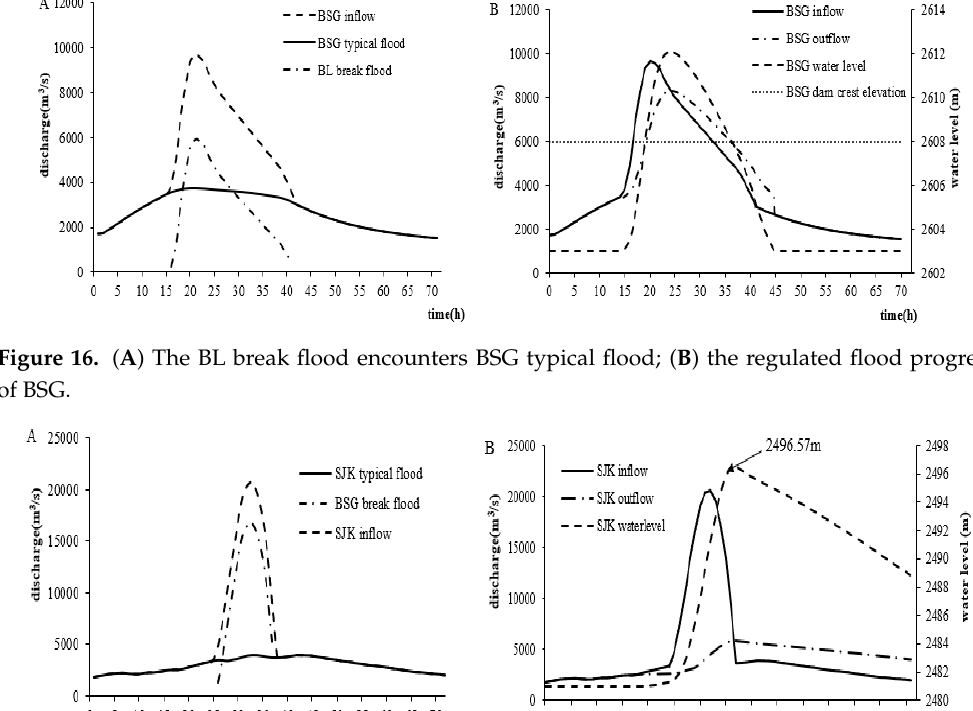
Figure 16. ( A ) The BL break flood encounters BSG typical flood; ( B ) the regulated flood progress of BGS.